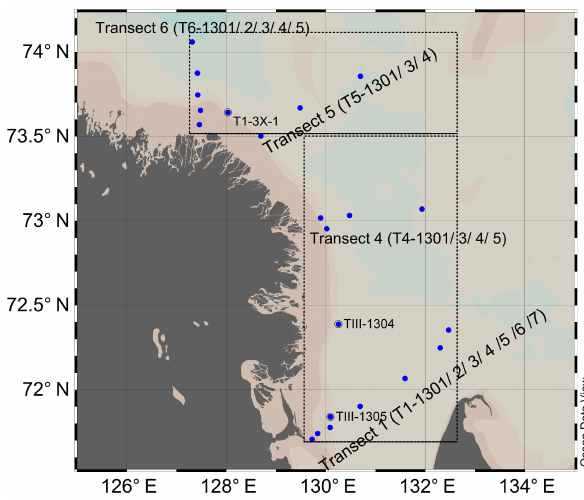
Figure 1. Map of the study area in September 2013 and sampling locations, with four transects heading from near shore to offshore. The dashed lines delineate the area used for the budget